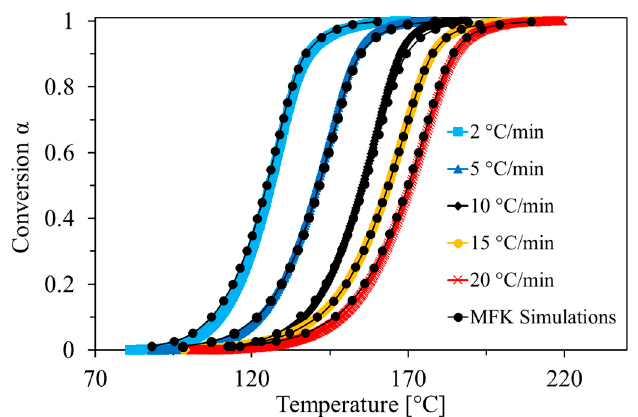
Figure 2. Conversion fits (simulations) after the Friedman method at different heating